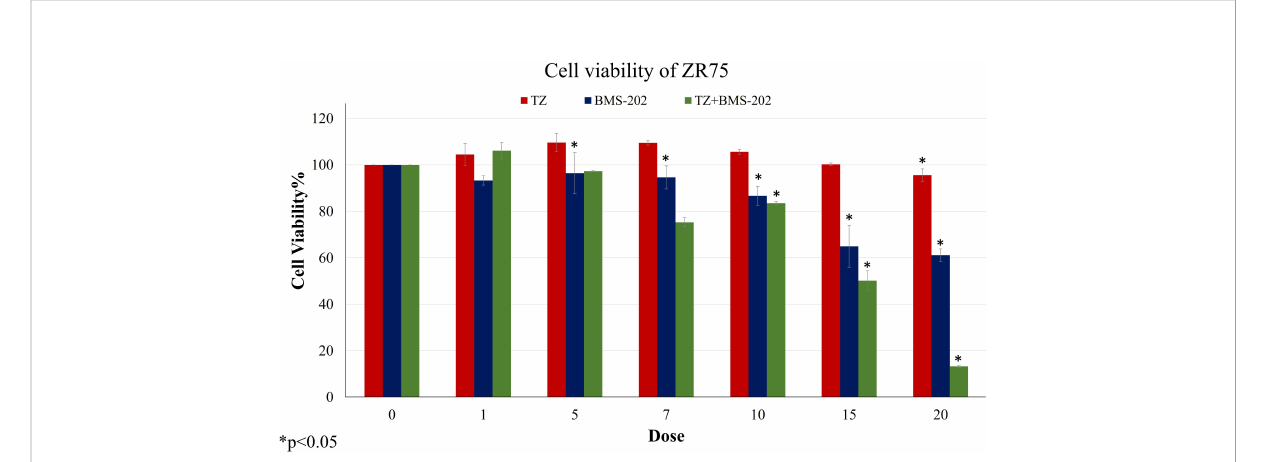
FIGURE 1 The effects of different concentrations of TZ, BMS-202, and a combination of both drugs on cell viability of ZR75 cell line. A signi fi cant dose- dependent decrease in cell viability was observed after treatment with the combination therapy. Data are presented as a percentage of viable cells ±